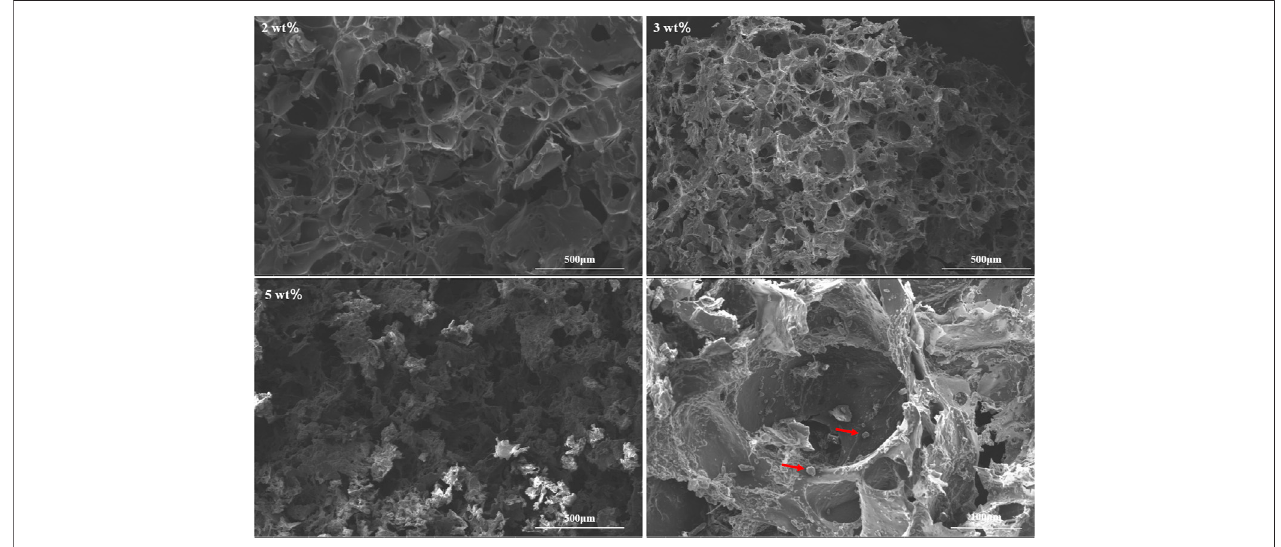
FIGURE 3 | Morphologies of hydrogels with different concentrations of 2, 3, and 5 wt% and celecoxib are observed in the porous hydrogel structure (red arrow).